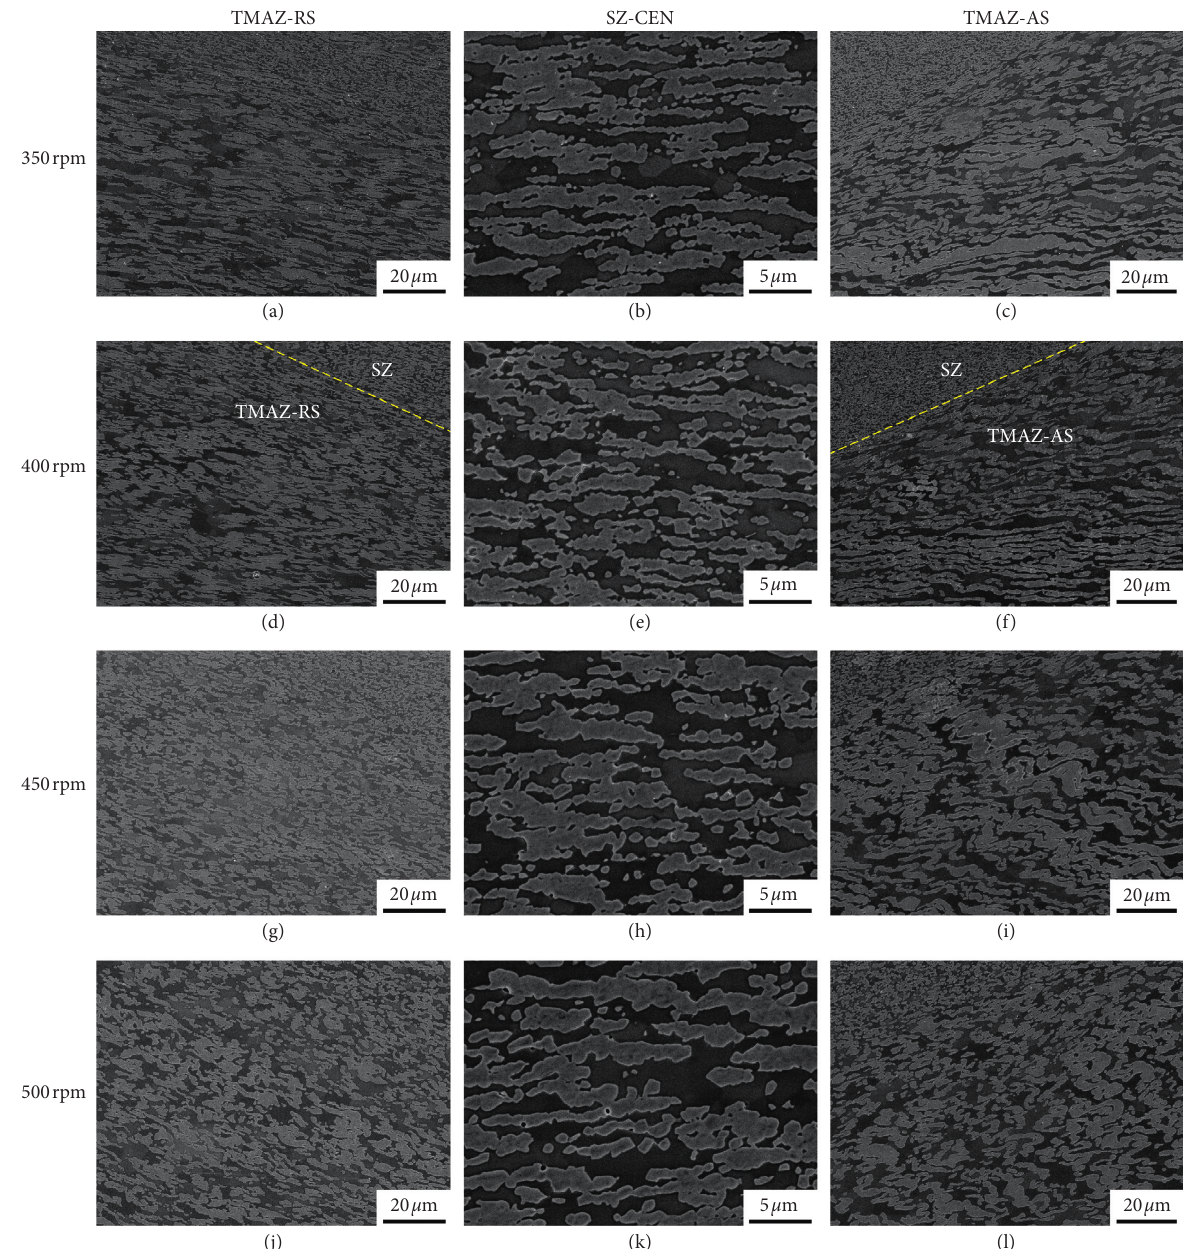
Figure 8: The SEM images in TMAZ and SZ of the joints welded at various rotation speeds (electroetched with KOH solution). Table 2: Volume fraction of ferrite in TMAZ and SZ of the joints welded at various rotation speeds. Volume fraction of ferrite (%) Rotation speed (rpm) TMAZ-RS SZ-CEN TMAZ-AS BM 500 46.0